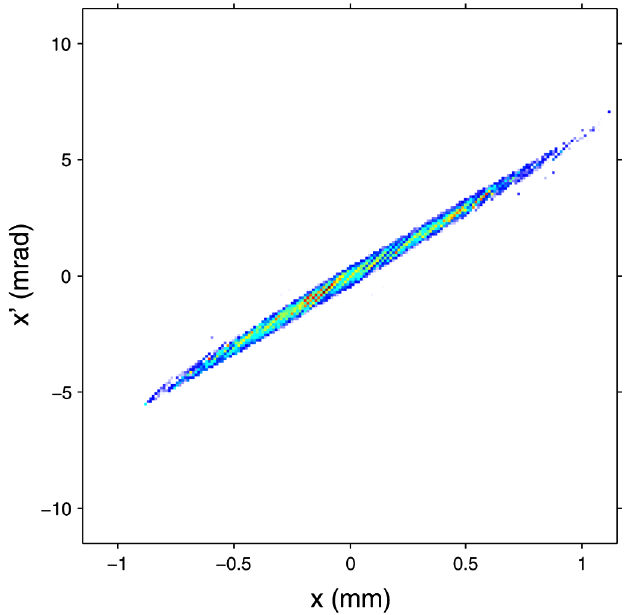
FIG. 6. (Color) Phase space distribution from the CT